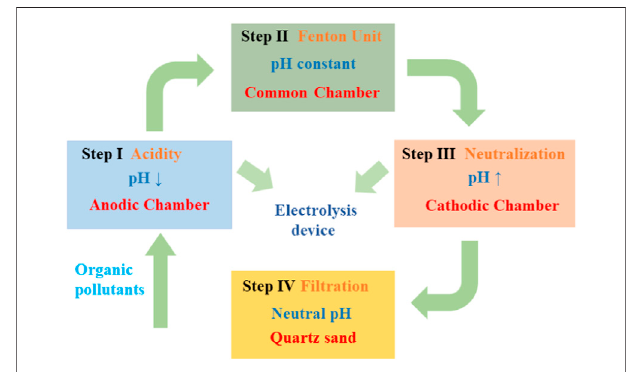
FIGURE 1 | Scheme of the iron cathode electrochemical Fenton (ICEF) system (steps 2 and 4) coupled with the pH-regulation divided electrolysis system (steps 1 and